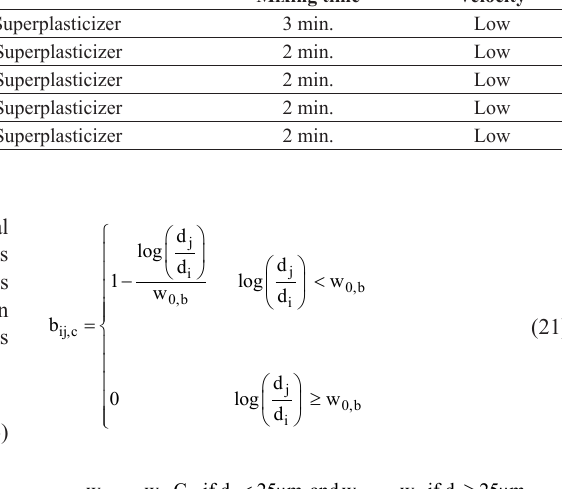
Table 2. Procedure for mixing the pastes, adapted from (Wong e Kwan, 2008). Mixing